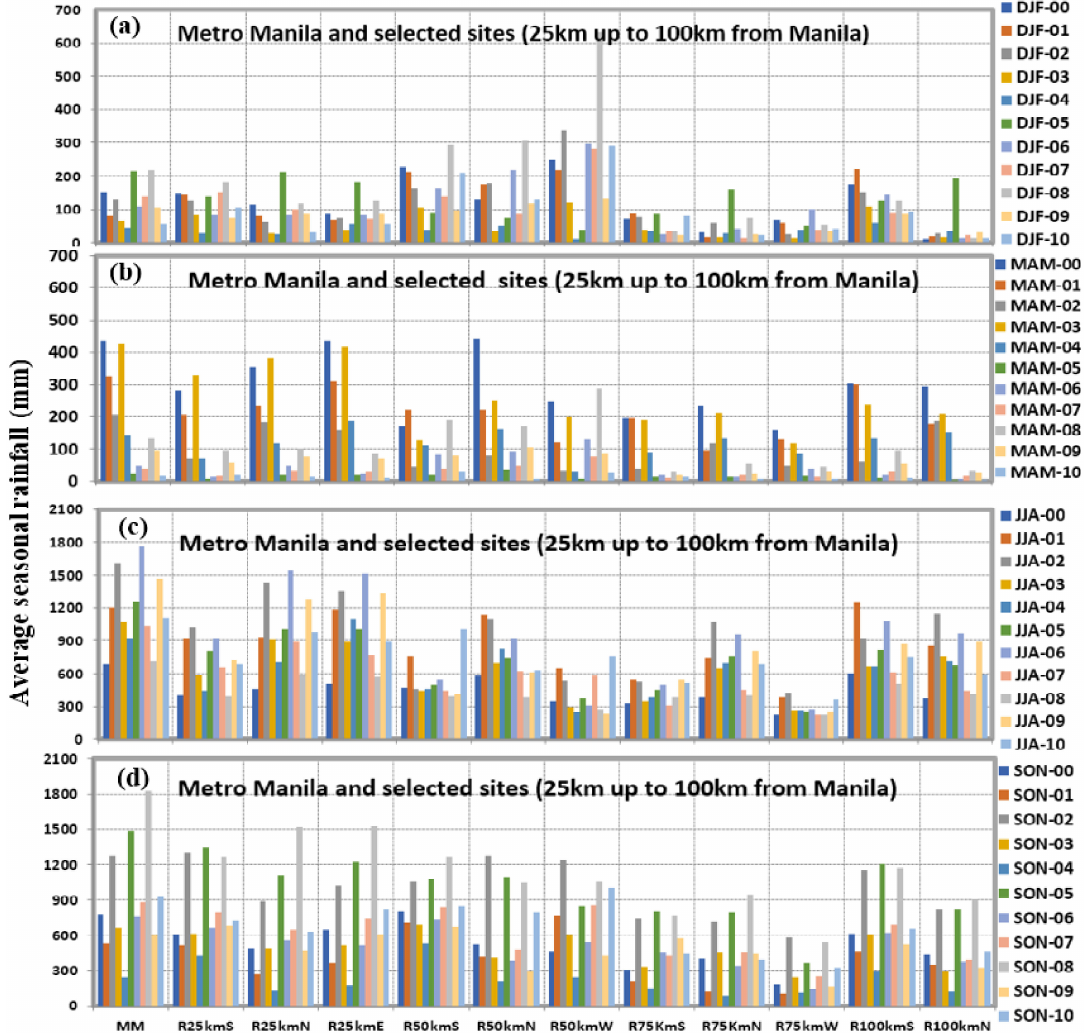
Figure 5. Volume of rainfall (mm) for 11 years (2000–2010) during the dry seasons (December, January, and February (DJF) and March, April, and May (MAM)) and wet seasons (June, July, and August (JJA) and September, October, and November (SON)) of the selected